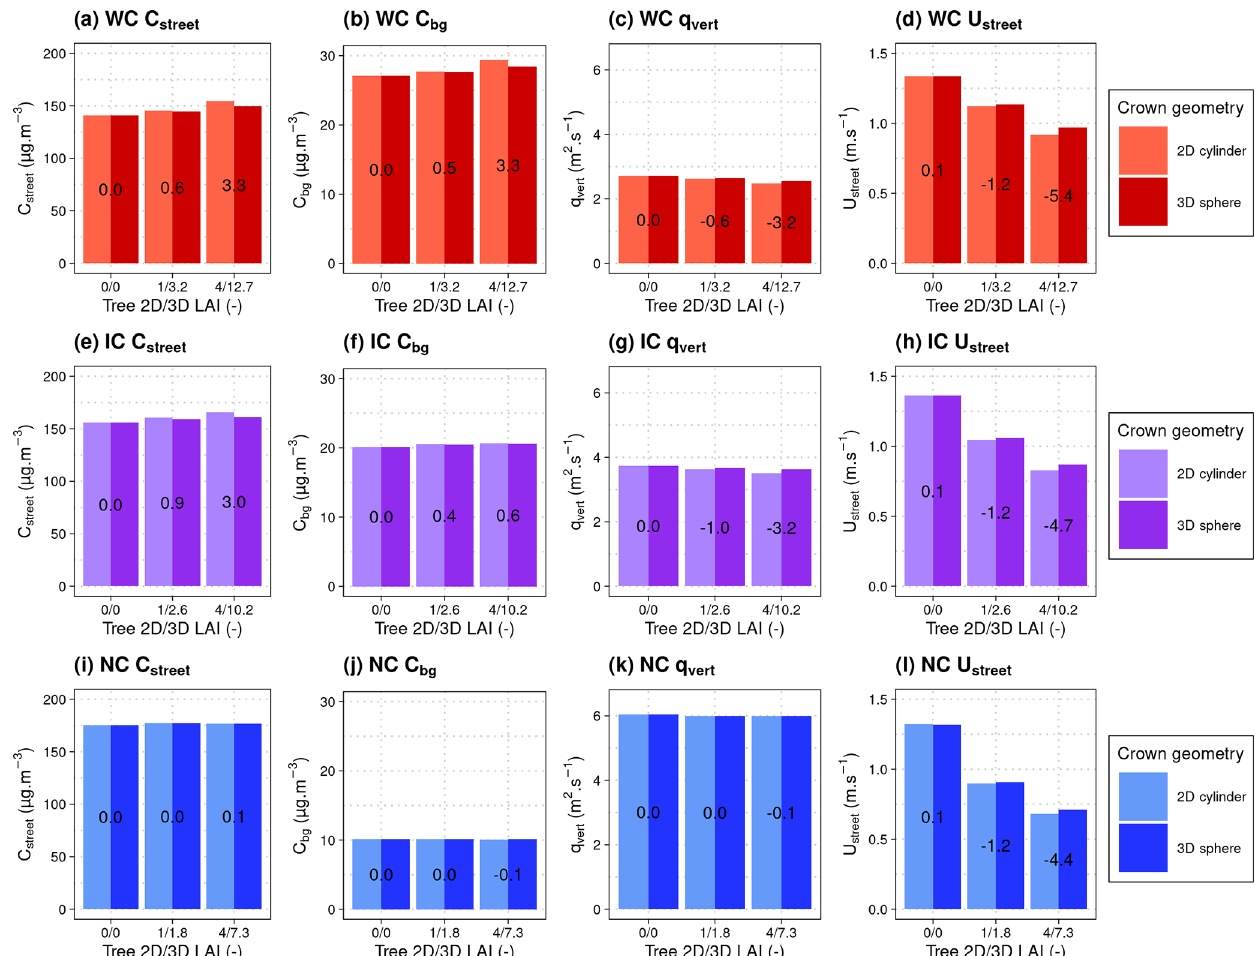
Figure B1. Comparison of C street (a, e, i) , C bg (b, f, j) , q vert (c, g, k) , and U street (d, h, l) for 2D and 3D simulations in the three canyons without and with trees of LAI 2D = 1 and 4. CVF 2D ≈ 10% and h/H ≈ 0 . 5 are fixed. The percentages written in the middle of the histogram bars correspond to the RD between the 2D and 3D